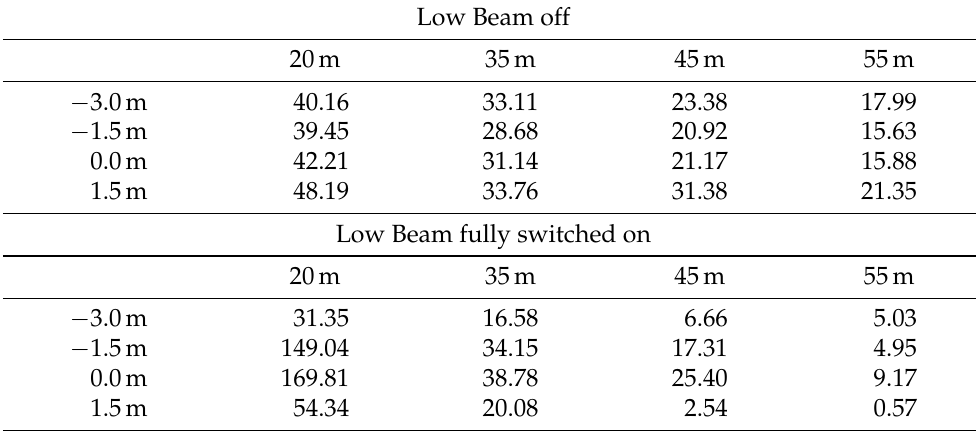
Table 3. Calculated Visibility Levels for test road 1, vehicle position